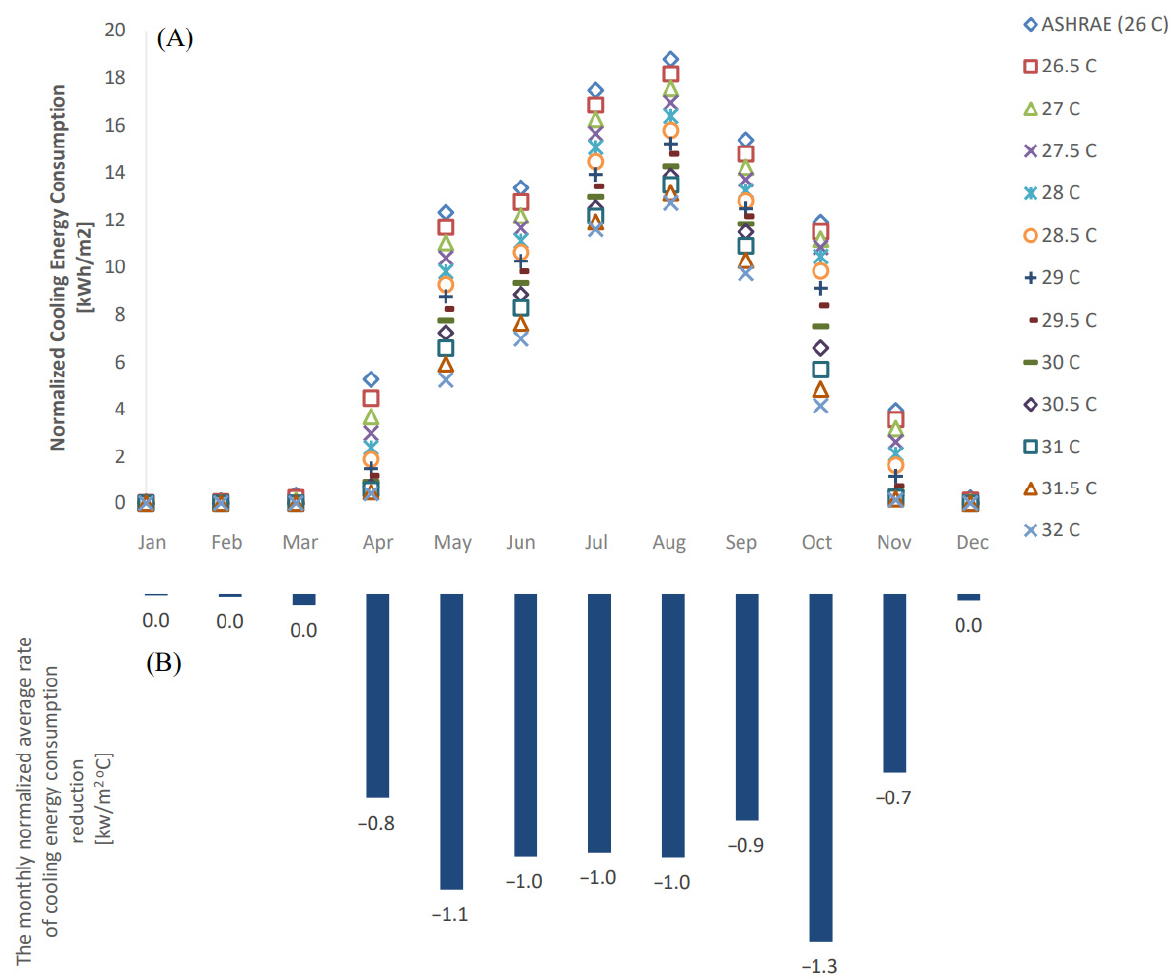
Figure 9. ( A ) The monthly normalized (by occupied area) cooling energy consumption with respect to the cooling setpoint; ( B ) The monthly average rate of normalized cooling energy consumption reduction with respect to the cooling setpoint temperature increase ( d ˆ E c / dt s ).